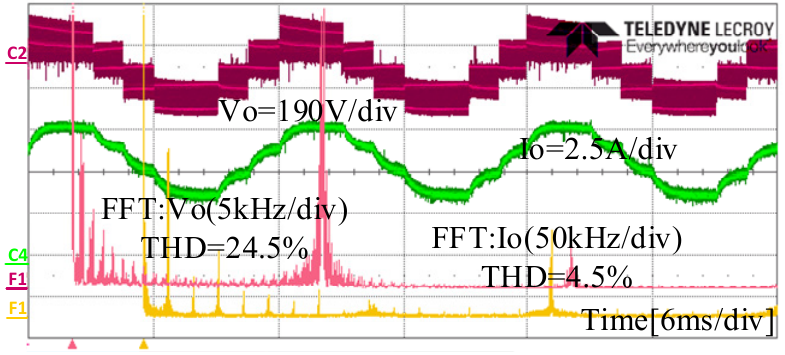
Figure 4 . Experimental frequency spectra and THD. Figure 4. Experimental frequency spectra and